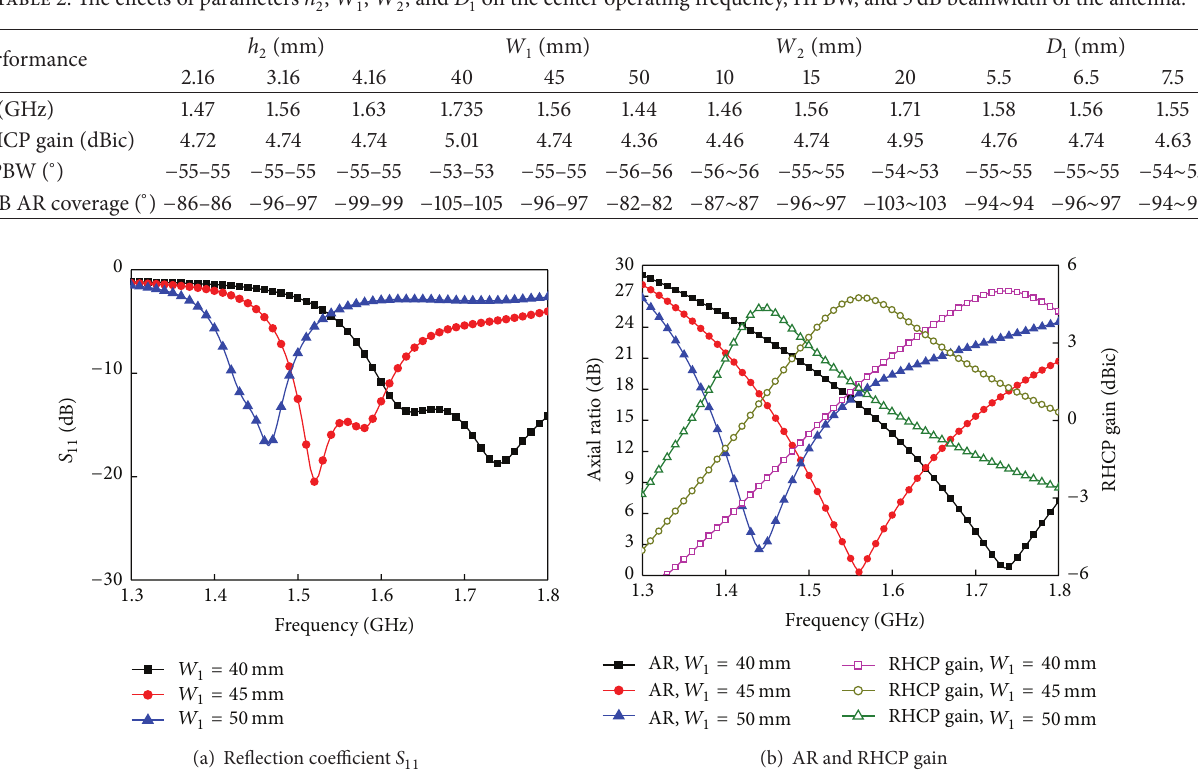
Figure 3: Effect of the bottom length 𝑊 1 of the trapezoid on the reflection coefficient, gain, and axial ratio of the